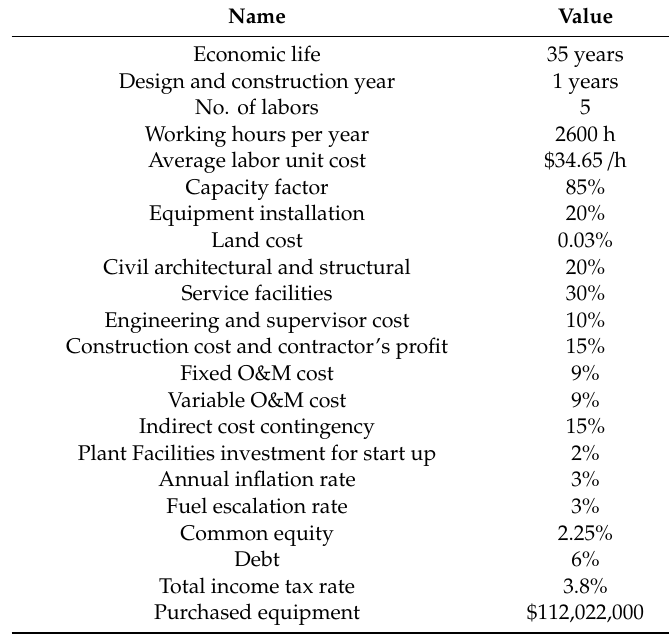
Table 7. Basis and assumptions for TCI calculation.